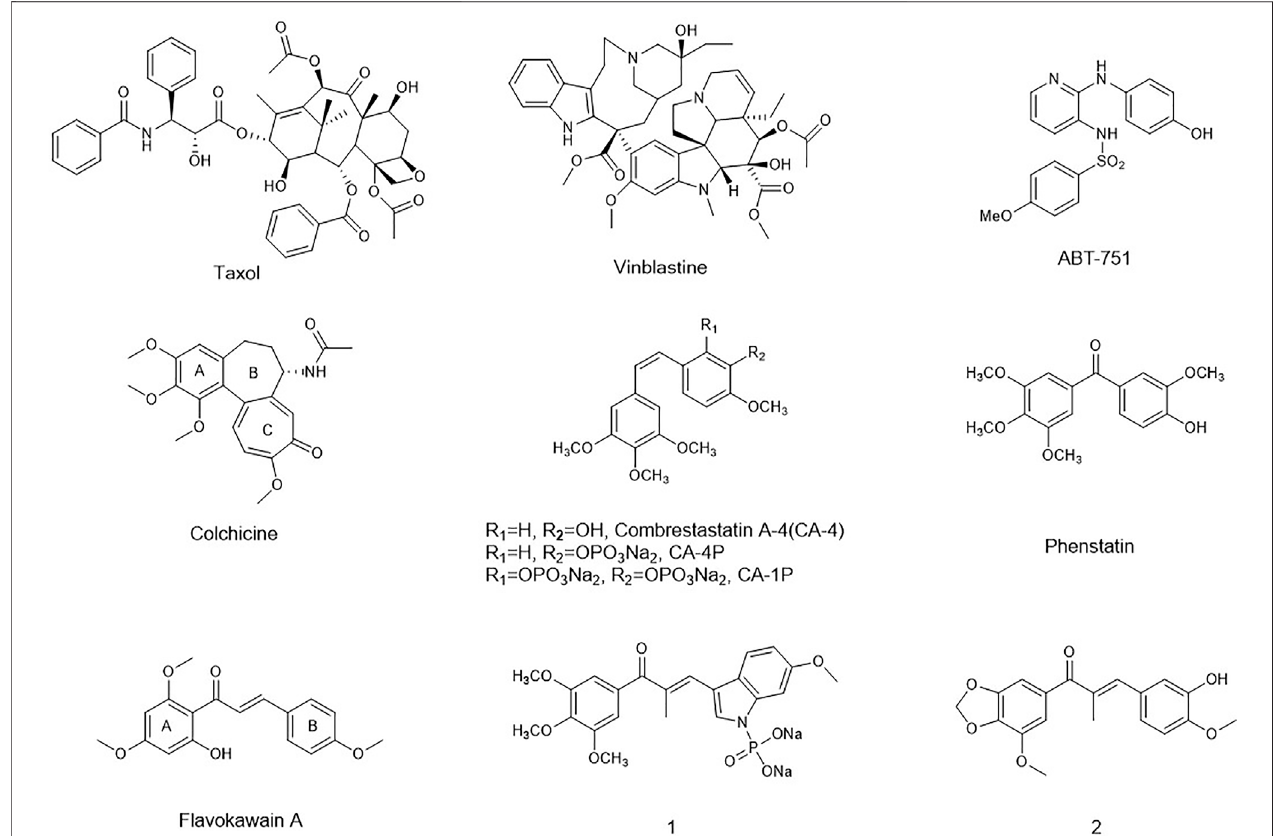
FIGURE 1 | Representative tubulin inhibitors with anti- angiogenesis potency.